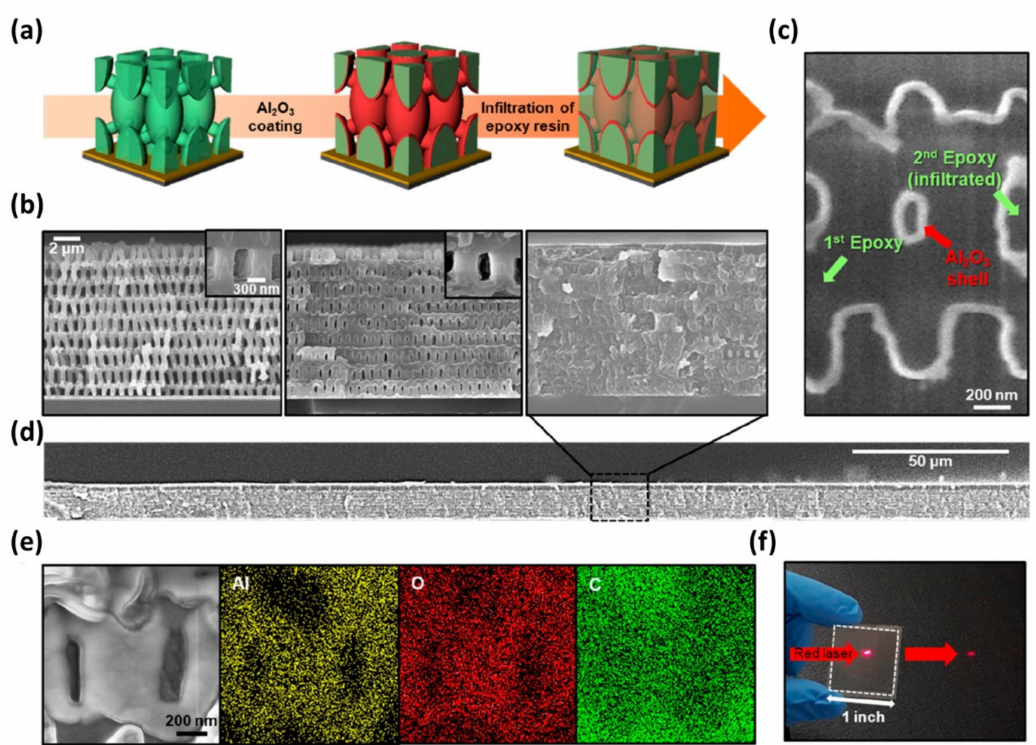
Figure 15. ( a ) Schematic illustration of the fabrication of 3D nanocomposite structure fabrication. ( b ) SEM cross-sectional image at each step. ( c , d ) Cross-section SEM image by intensive ion beam